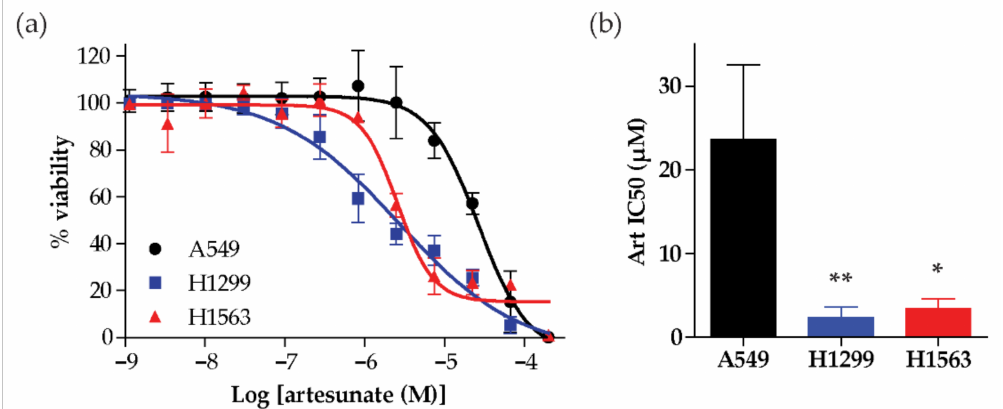
Figure 1. Artesunate sensitivity across a panel of non-small-cell lung cancer (NSCLC) cell lines. ( a ) Cells were treated with a serially diluted concentrations of artesunate for 96hr. Each cell lines was normalized to cells treated with 0.1% DMSO (dimethyl sulfoxide) as a control and is graphed as the mean ± SD, n = 6. ( b ) The mean IC50 of artesunate (Art) in each cell line is graphed ± SD. p -values were calculated using a two-tailed t -test (* p = 0.0290 or ** p = 0.0007 compared to